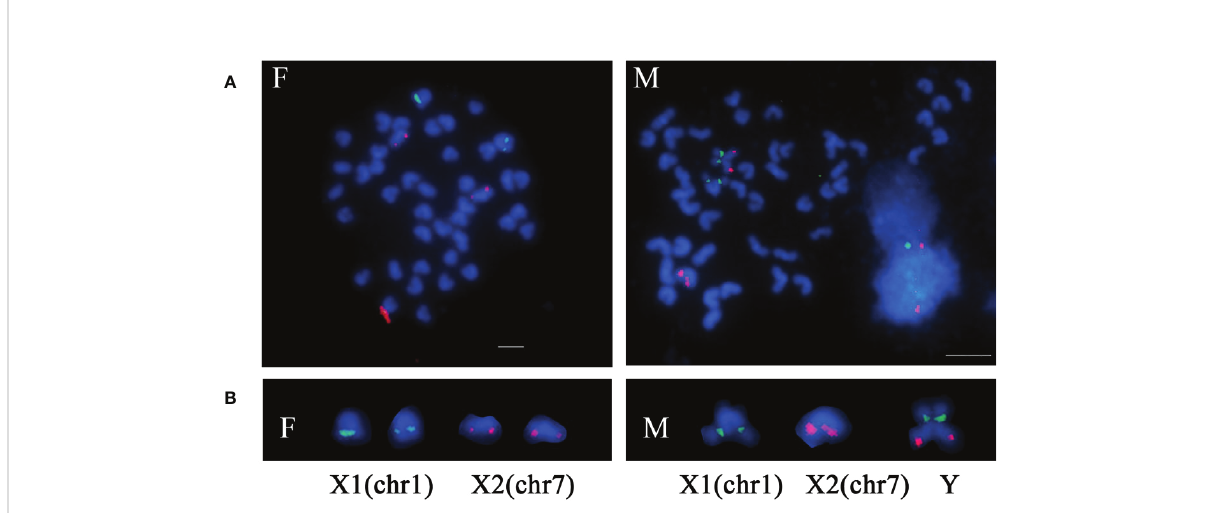
FIGURE 4 Sex chromosome fusion in spinyhead croaker. (A) Metaphase spreads with FISH signal. (B) The sex chromosomes. The red signals were derived from BAC 101-J21 and BAC 101-K12 corresponding to Chr.7, and the green signals were derived from 18S rDNA corresponding to Chr.1. F indicates female. M indicates male. Bar represents 5 m